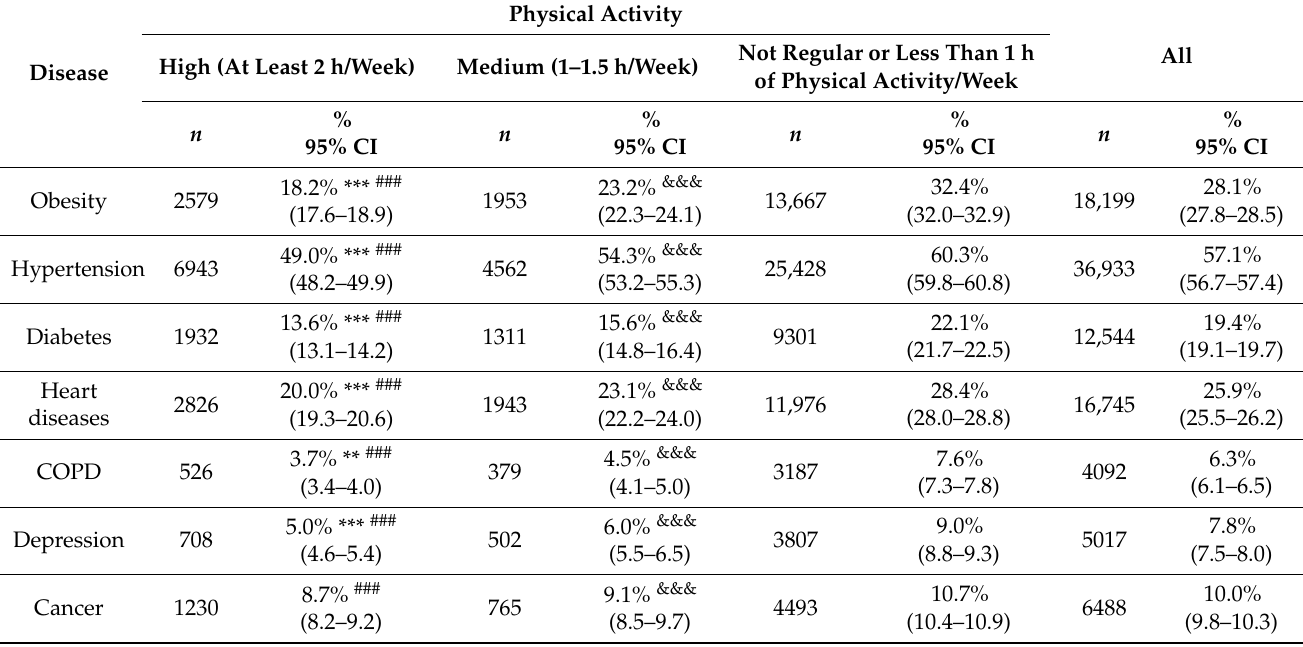
Table 7. Prevalence of diseases in different physical activity groups.